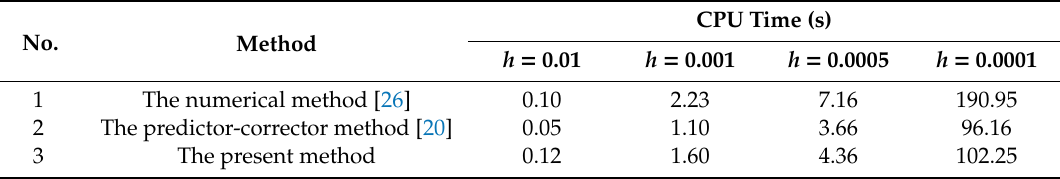
Table 2. Time consumptions of numerical computing for di ff erent